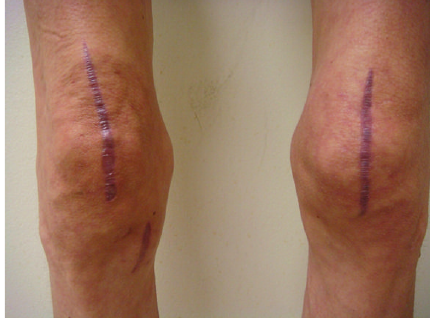
Figure 6: Healed lesions of the knees.